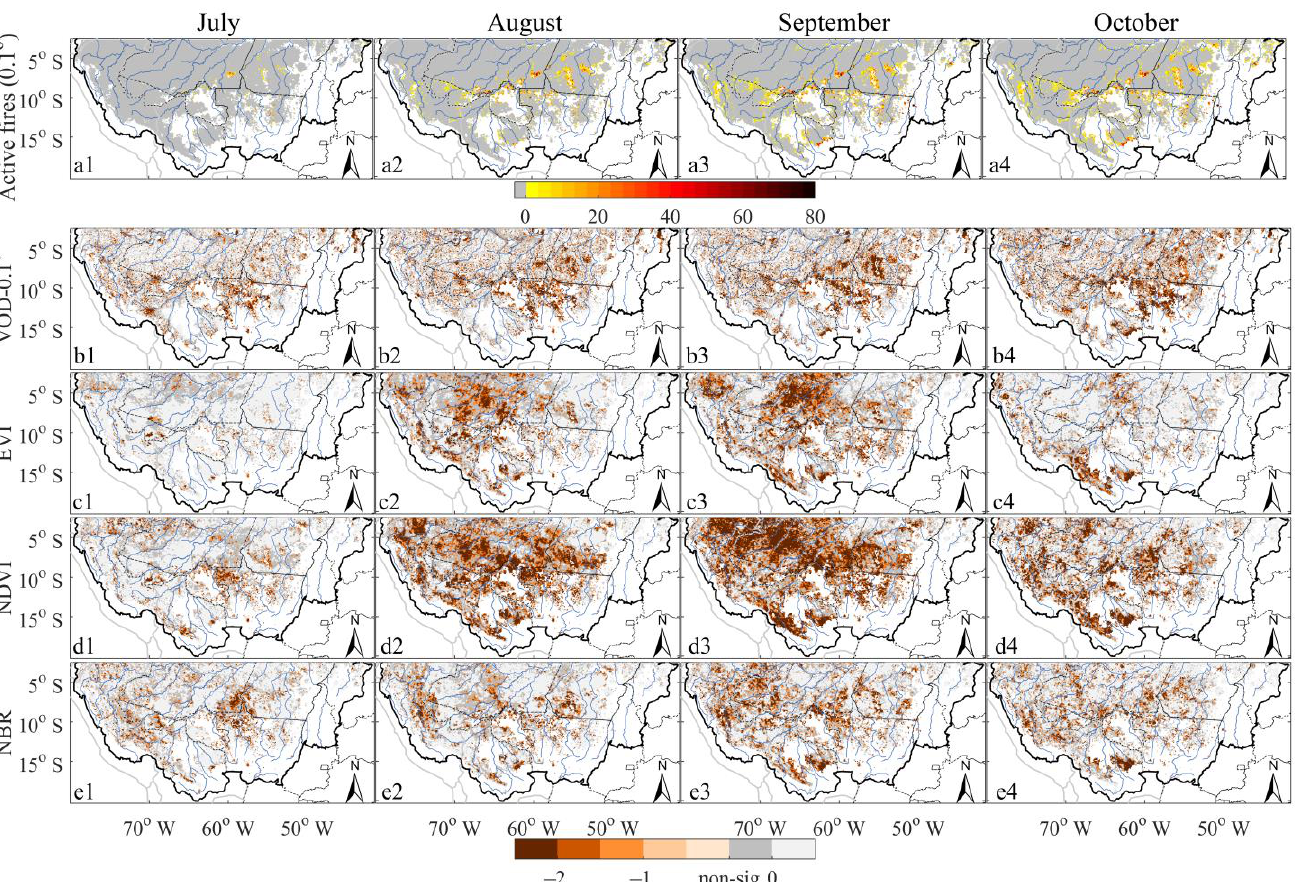
Figure 3. Spatial distribution of cumulative active fires on 0.1° ( a1 – a4 ) grid cells from July to October 2019. Spatial distribution of standardized anomalies for July‒October 2019 in ( b1 – b4 ) VOD-0.1°; ( c1 – c4 ) EVI; ( d1 – d4 ) NDVI; and ( e1 – e4 ) NBR with the 0.1° spatial resolution.